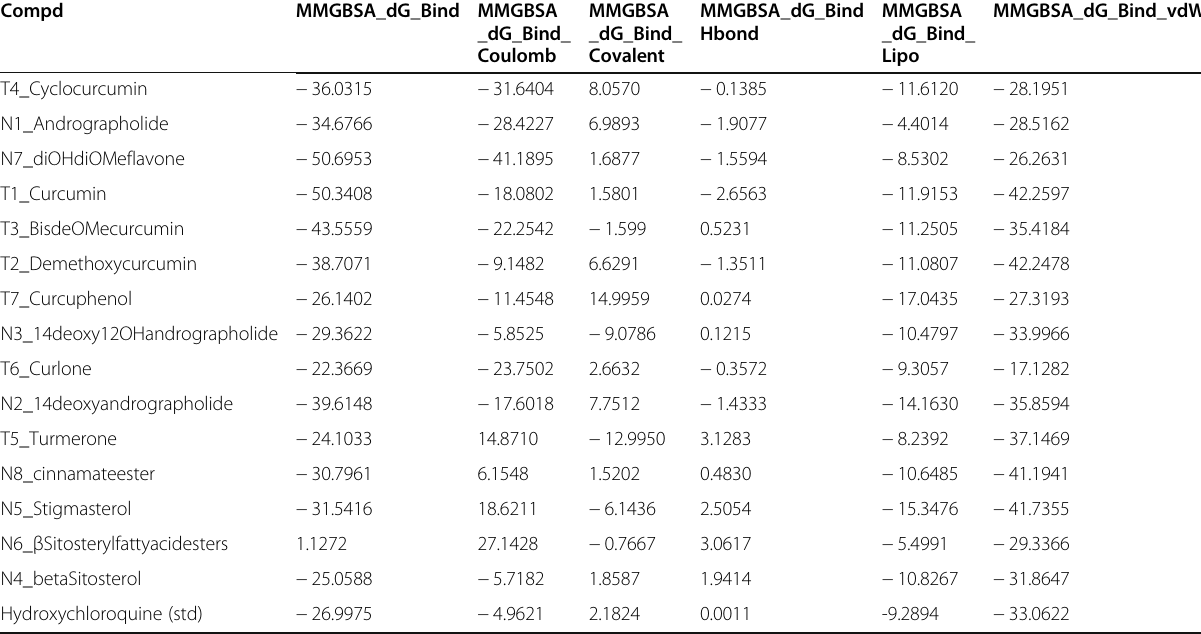
Table 3 Binding free energy calculation using Prime/MM-GBSA approach